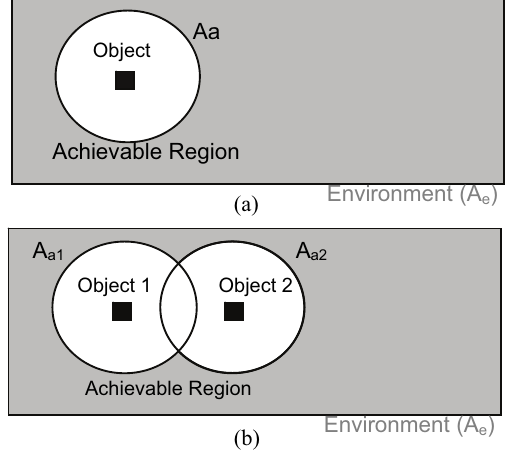
Fig. 12. Achievable regions in: